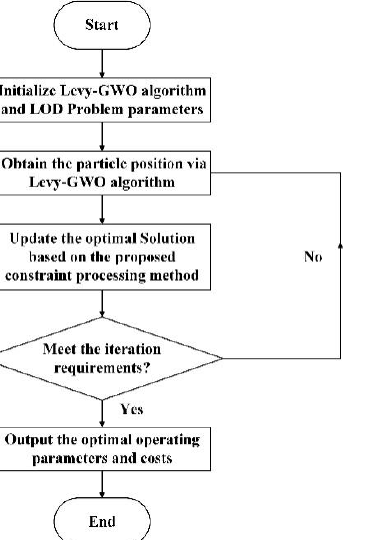
Figure 3. Flow chart of solving the LOD problem through the Levy–GWO algorithm.